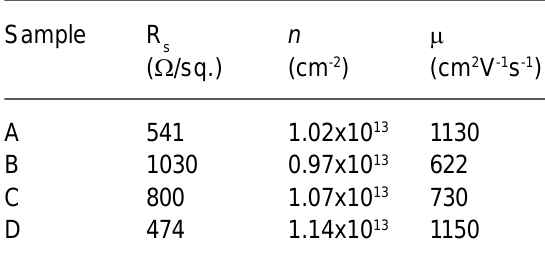
Table 1. Samples resistance, carrier concentration and mobility measured by Hall method in van der Pauw